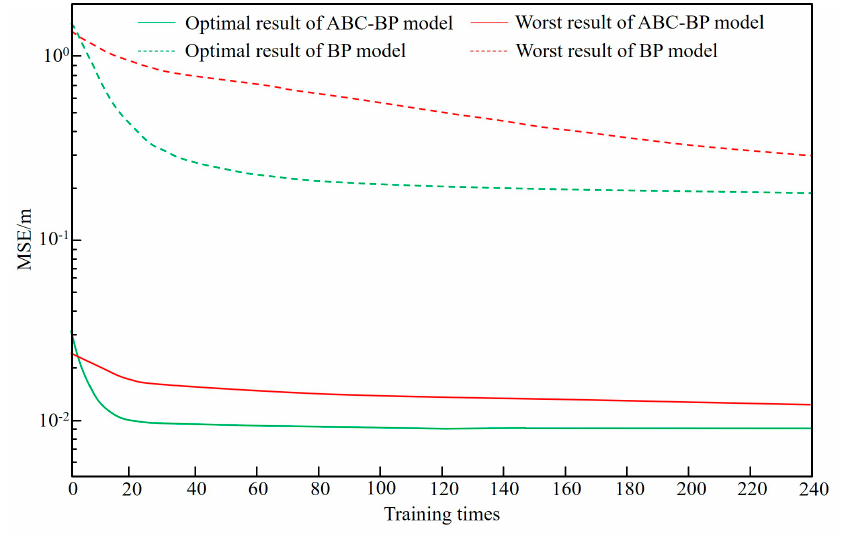
Figure 6. Variation curve of MSE in the optimal and worst training of the ABC-BP and BP models.